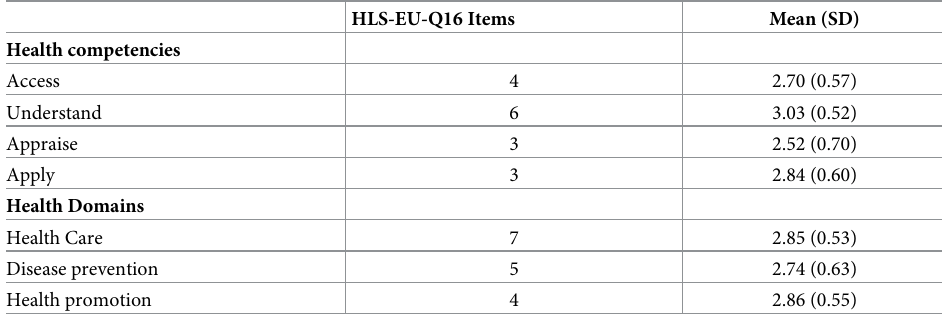
Table 2. Health literacy by health domains and health competencies (n =